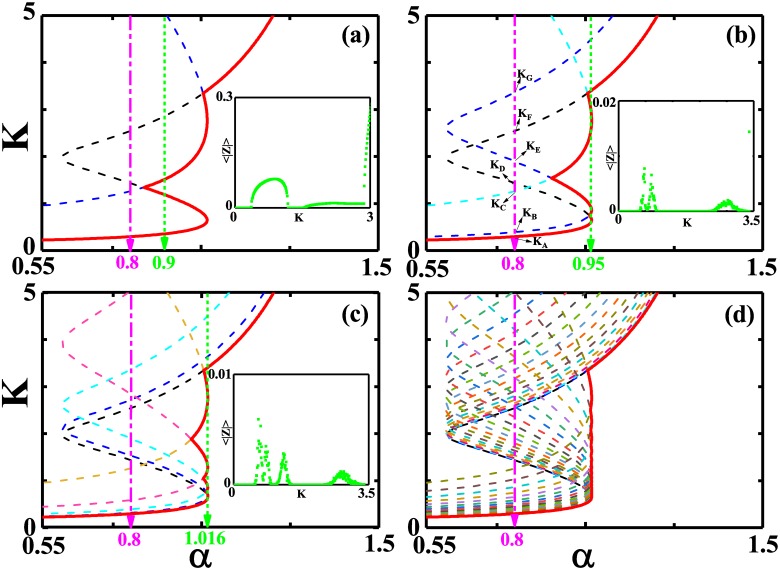
The stability diagrams of the incoherent state in the plane of the phase lag α and the coupling strength K for different coupling radius.In each plot, we present the critical curves with Re(λq) = 0 for different q and the boundary of the stability regime of the incoherent state, denoted by the curve in red, is made up of these critical curves with the largest α at a given K. (a) σ = 0.4, and q = 0, 1. q = 0 in black and q = 1 in blue. (b) σ = 0.2, and q = 0, 1, 2. q = 0 in black, q = 1 in blue and q = 2 in cyan. (c) σ = 0.1, and q = 0, 1, ⋯, 4. (d) σ = 0.02, and q ≤ 20. Inset in each plot shows 〈|Z|〉 against K for the intermediate coupling strength at α denoted by the green line. γ1 = 1, γ2 = 0.01, and p = 0.9. The denoted coupling strengths in (b): KA ≃ 0.29, KB ≃ 0.39, KC ≃ 1.27, KD ≃ 1.43, KE ≃ 1.9, KF ≃ 2.5, and KG = 3.6.